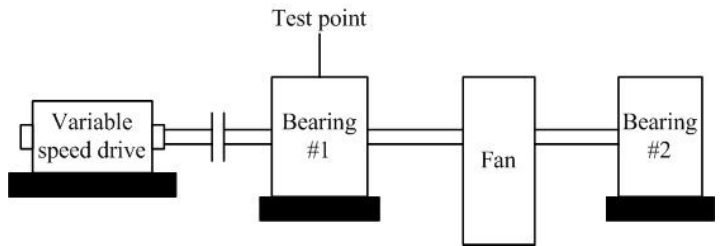
Figure 7. The structure diagram of the fan.